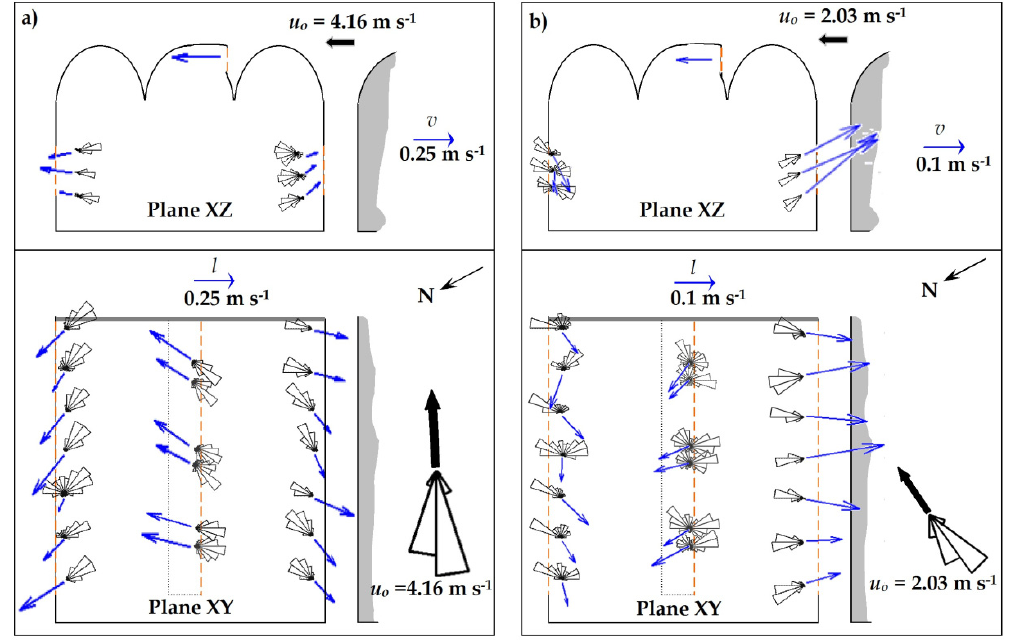
Figure 4. Polar histograms of the horizontal angle and projection of the air velocity at the middle of the side vents and at the roof vent. Experiments 2 (a) and 4 (b) carried out on 08/04/2009 and 07/05/2009,